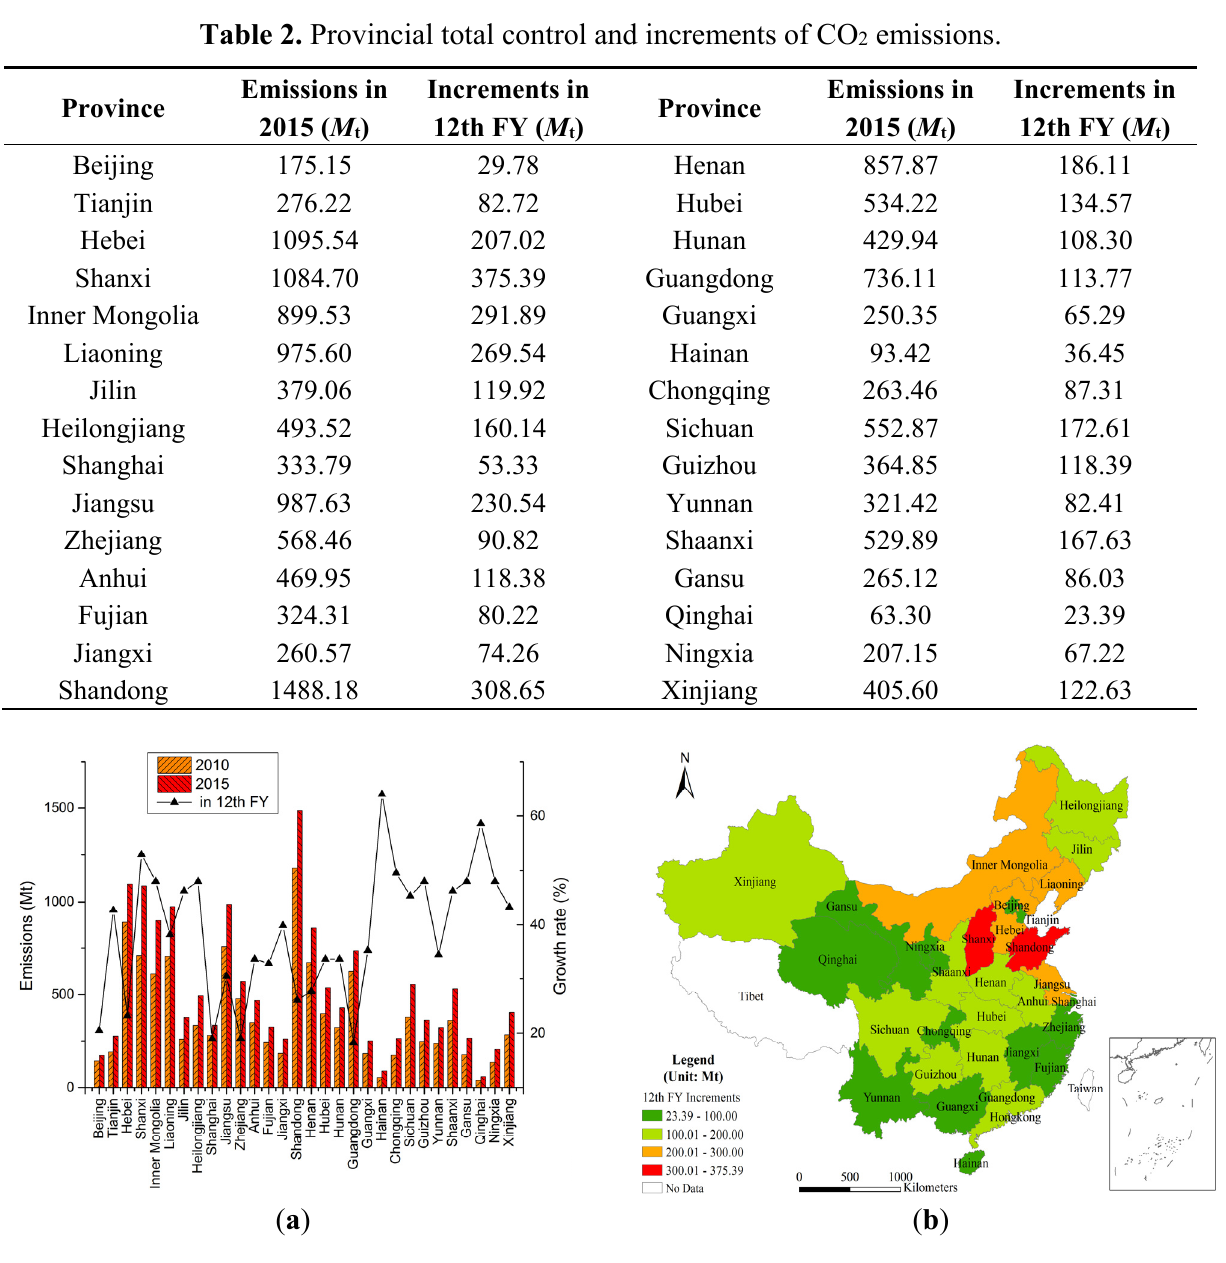
Figure 8. Provincial variation in CO 2 emission ( a ) Temporal variation of emissions